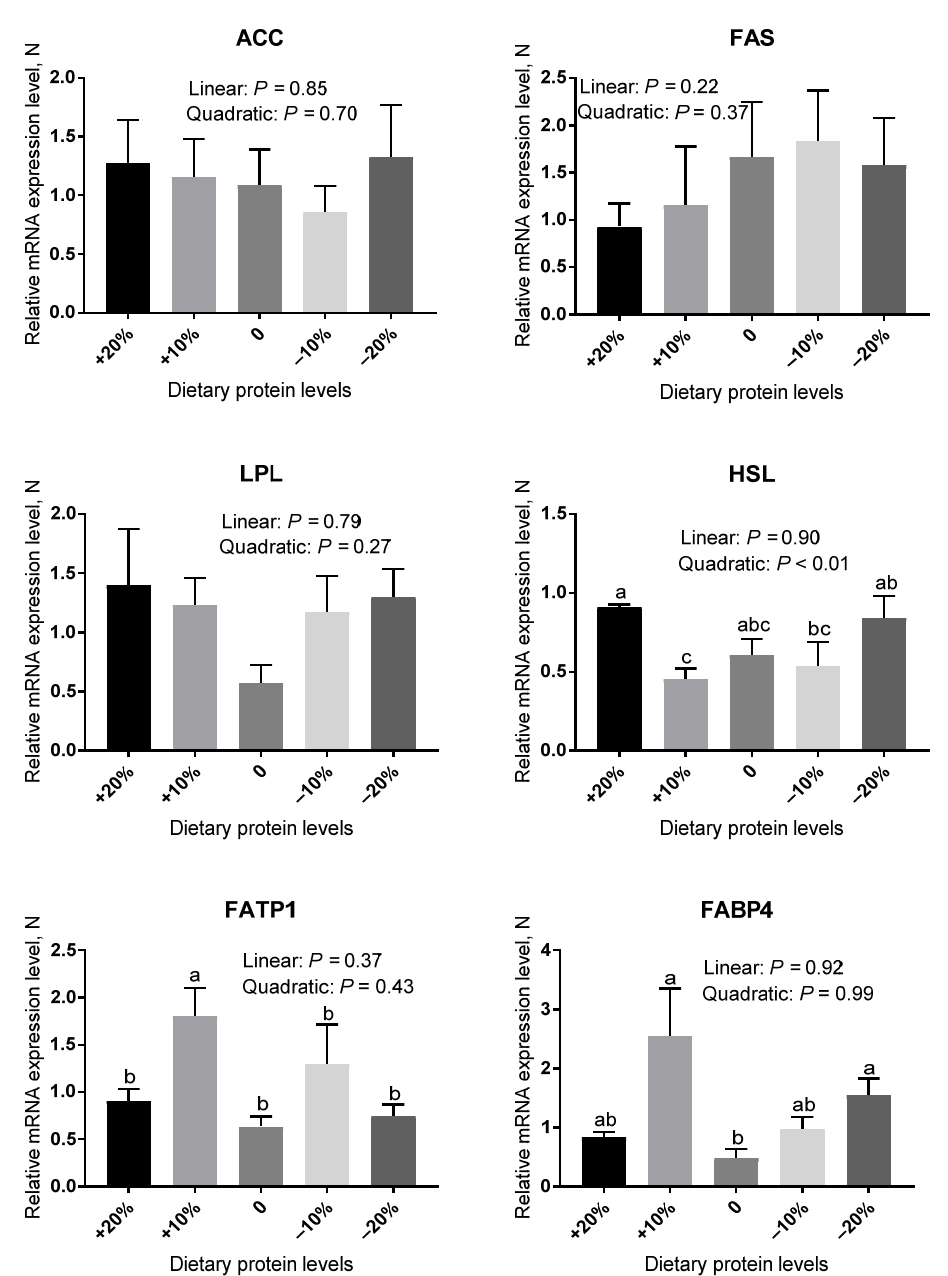
Figure 2. The relative mRNA expression level of genes related to lipid metabolism in the PRA of pigs fed different protein levels. Values are means, with their standard errors represented by vertical bars. a,b,c Values ( n = 6) within a row with different lowercase letters differ significantly ( p < 0.05) by the Kruskal–Wallis test.